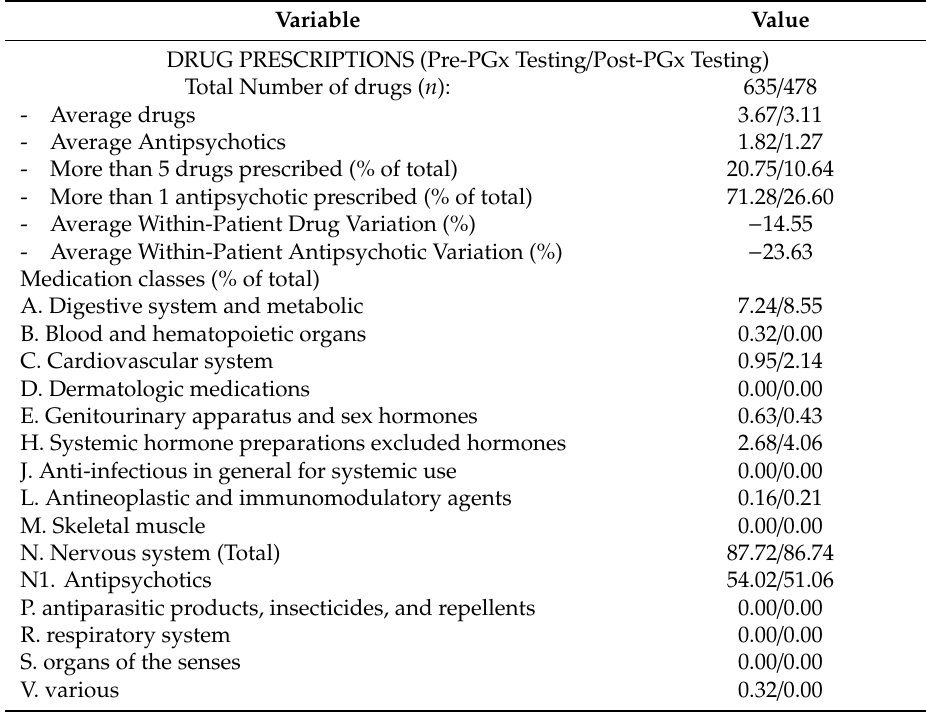
Table 3. Drug prescriptions.